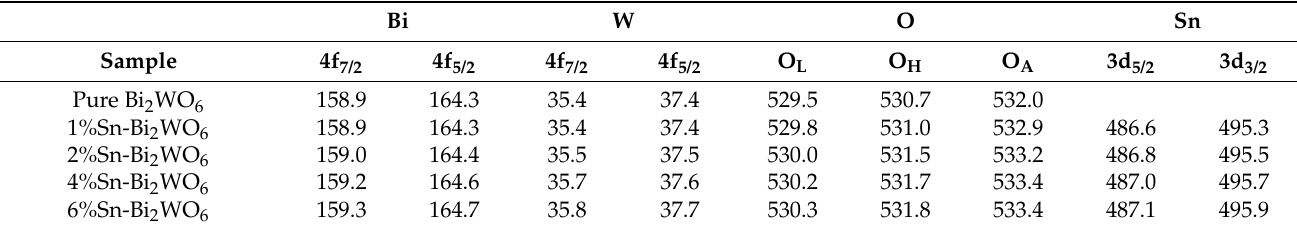
Table 2. Binding energies of